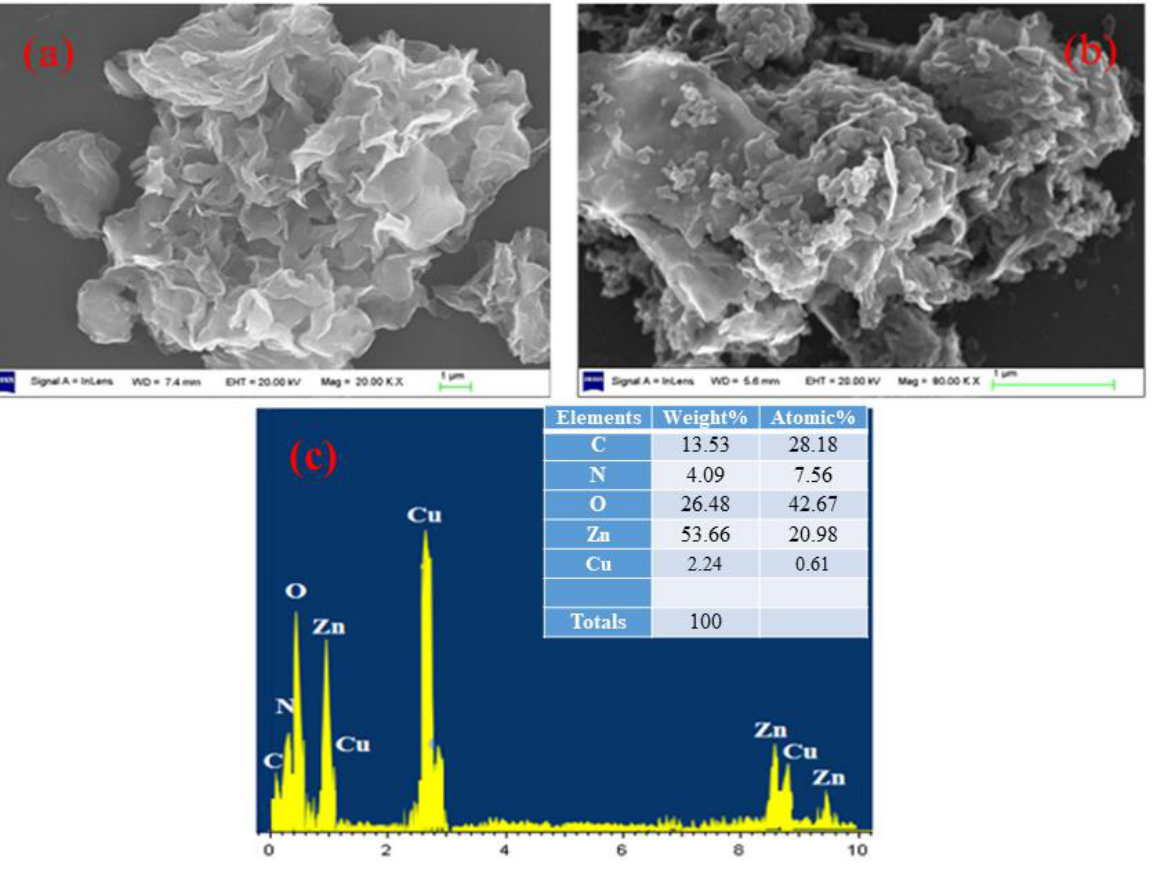
Figure 3. SEM images of ( a ) of g – C 3 N 4 , ( b ) ZnO – CuO/g – C 3 N 4 , and ( c ) EDS analysis of ZnO – CuO/g – C 3 N 4 composite.